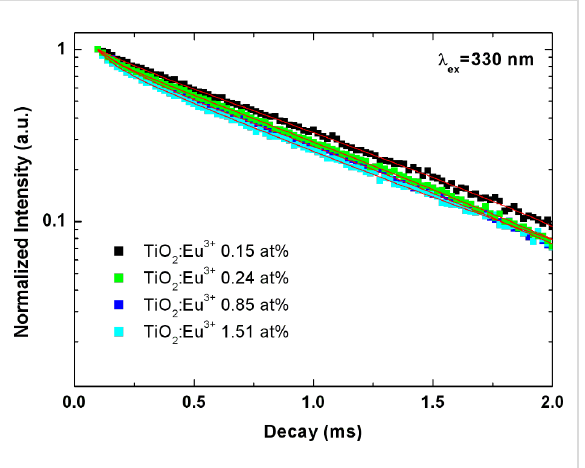
Figure 6: Decay of the TiO 2 :Eu emission intensity at 617 nm with time for excitation at 460 nm.